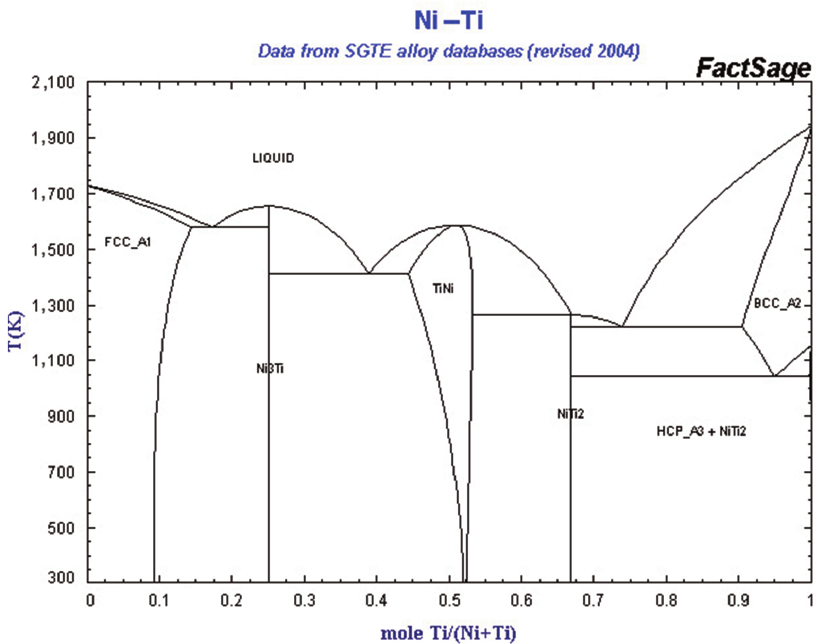
Figure 1: The Ni – Ti phase diagram from FactSage program.